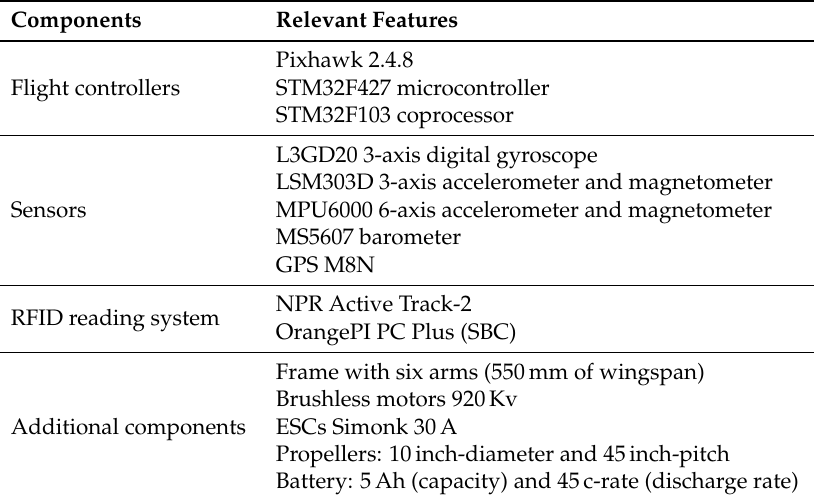
Table 3. Main features of the UAV